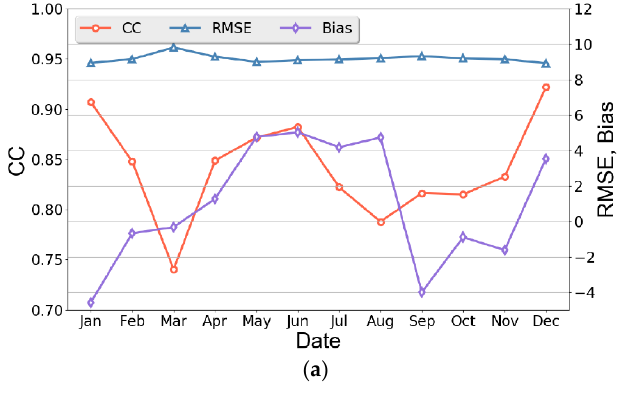
Figure 6. Scatterplots and statistics of ( a ) AI-generated reflectance on 25 January, 04:00 UTC (daytime) and ( b ) AI-generated radiance on 25 January, 16:00 UTC (nighttime).